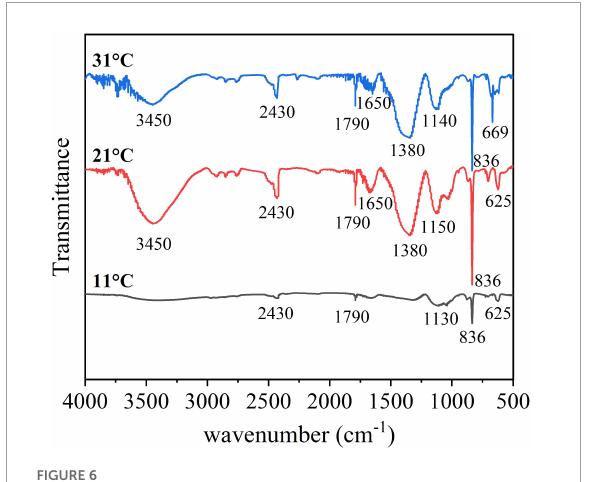
FIGURE6 FTIR spectra of the EPS in different